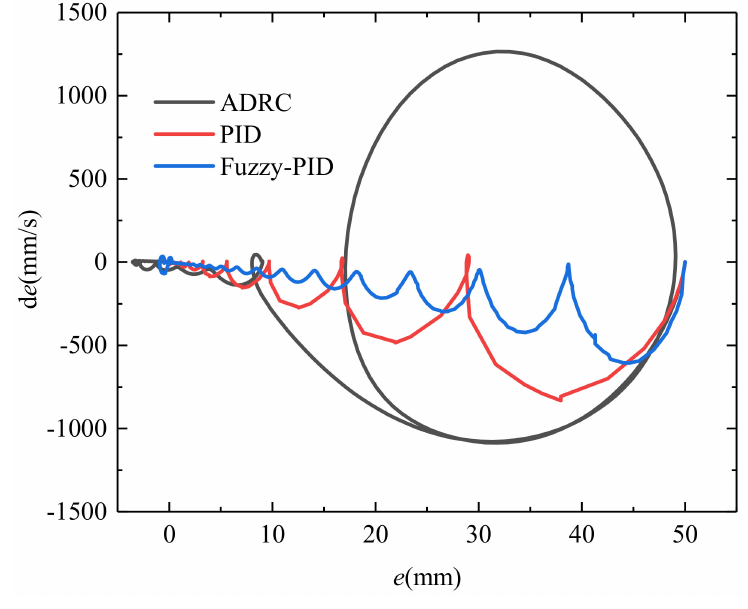
Figure 12. Phase path for the displacement error from 0mm to 50 mm.